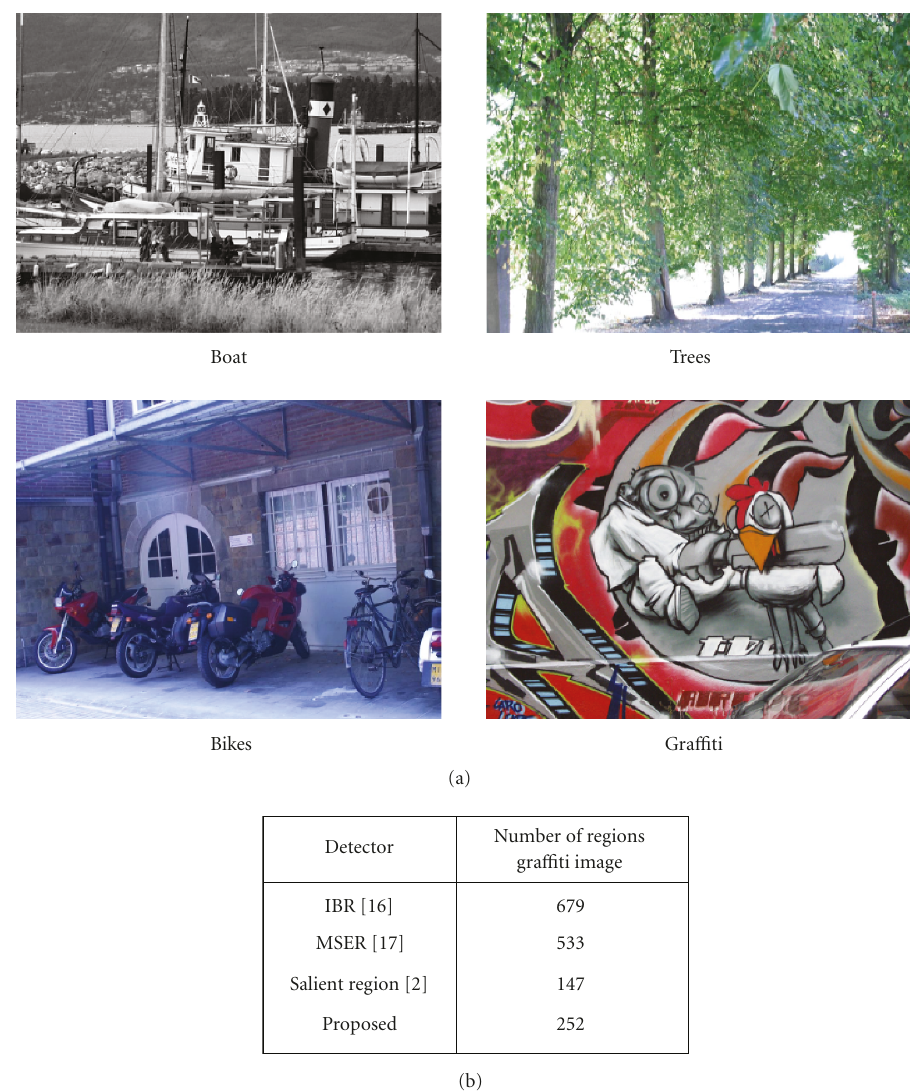
Figure 9: (a) Image examples of the standard data set. (b) Comparison with other region detectors with the number of regions detected in the GRAFFITI